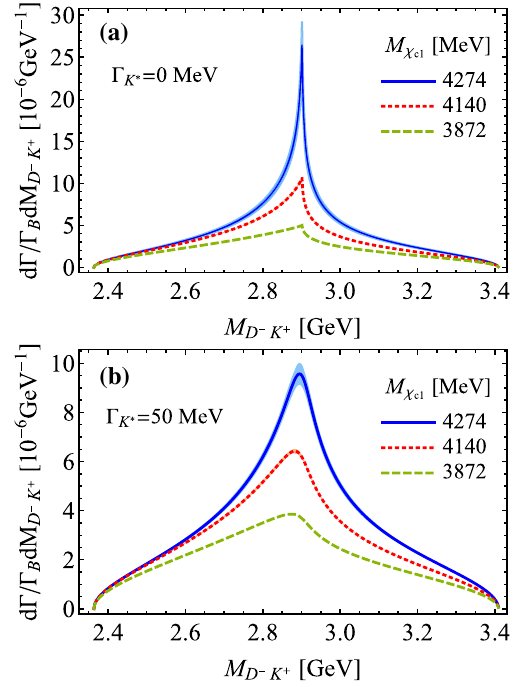
Fig. 2 Invariant mass distribution of D − K + via the rescattering pro- cesses in Fig. 1a. The mass and width of intermediate state χ c 1 are taken to be those of χ c 1 ( 4274 ) (solid line), χ c 1 ( 4140 ) (dotted line), and χ ( 3872 ) (dashed line) given by PDG [19], separately. The width of c 1 intermediate state K ∗+ is set to be a 0 MeV and b 50 MeV, respectively. The bands are obtained by taking into account uncertainties of the mass and width of intermediate particles